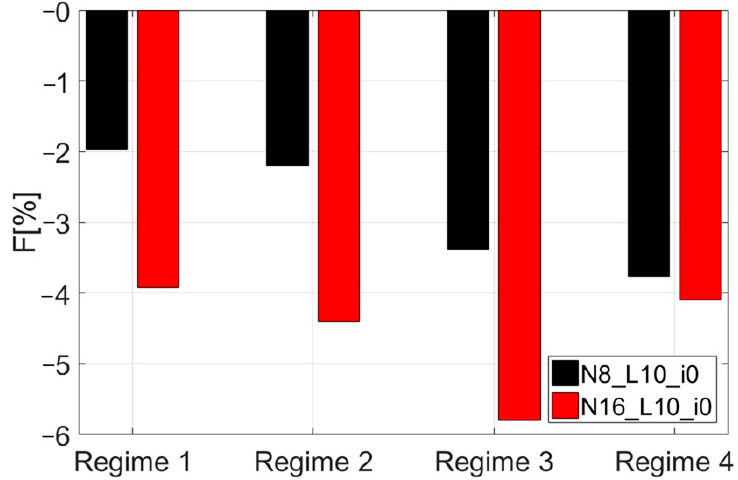
Figure 8. Variation of the engine thrust depending on the regime and nozzle type.